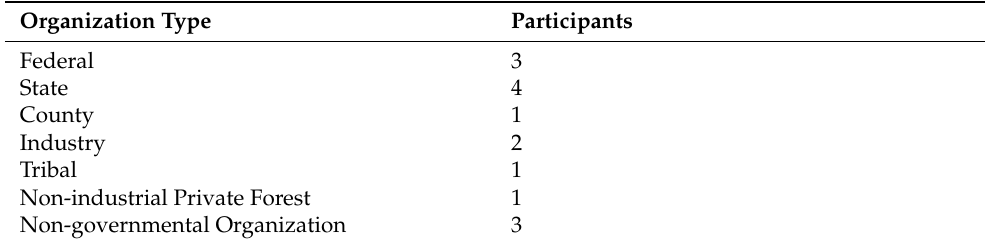
Table 1. Participants’ organizations represented in the focus groups, including resource managers from both rural and urban forestry settings throughout Minnesota. Federal organizations represented included the Natural Resources Conservation Service, the Northern Institute of Applied Climate Science, and the USDA Forest Service. Multiple state representatives participated in the focus groups, including those from the Minnesota Department of Natural